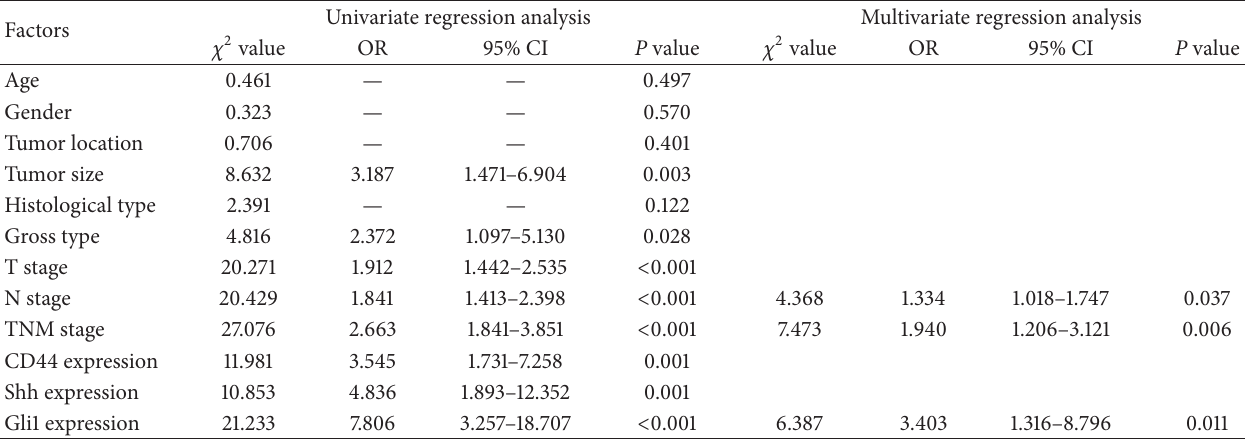
Table 3: Univariate and multivariate analysis for disease-free survival in gastric cancer after radical